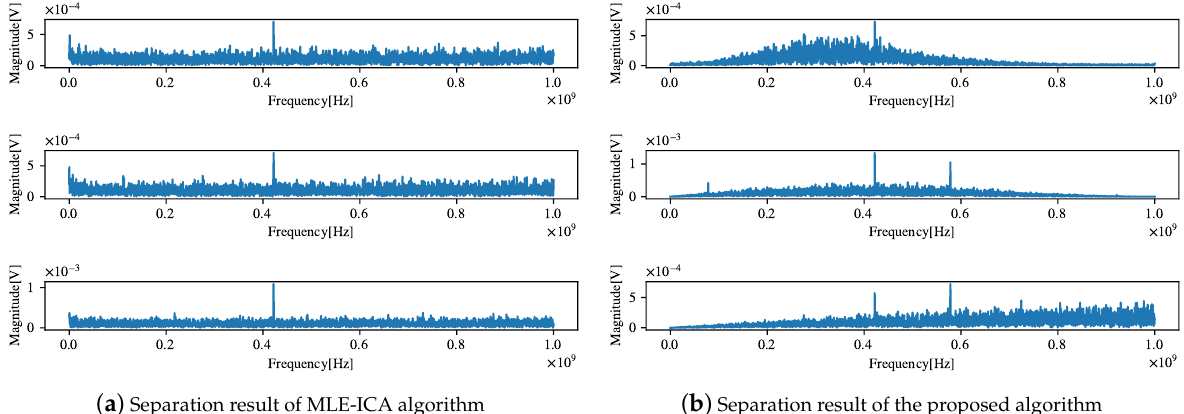
( b ) Separation result of the proposed algorithm Figure 23. Separation results of real-ship